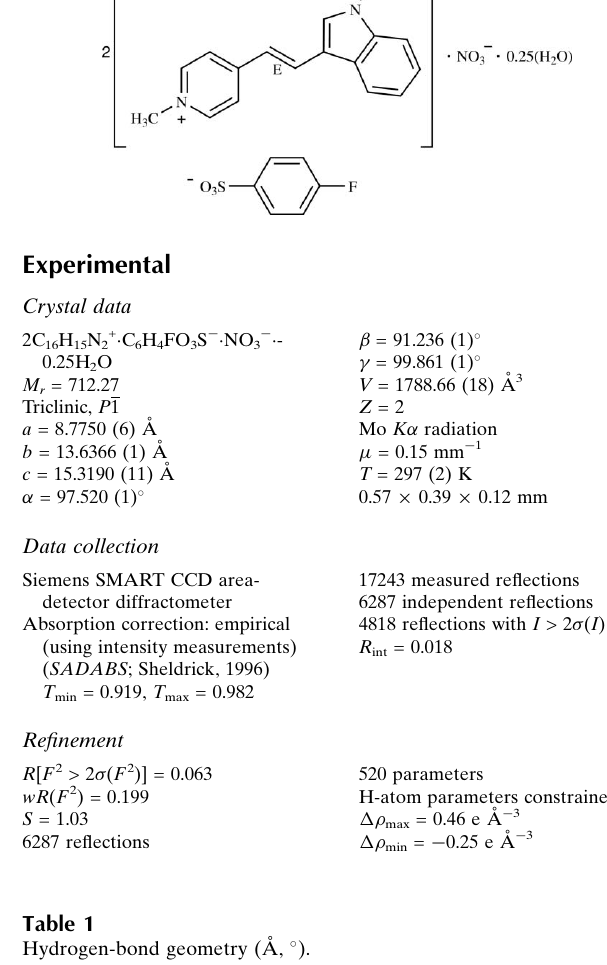
Hydrogen-bond geometry (A˚ , (cid:3)